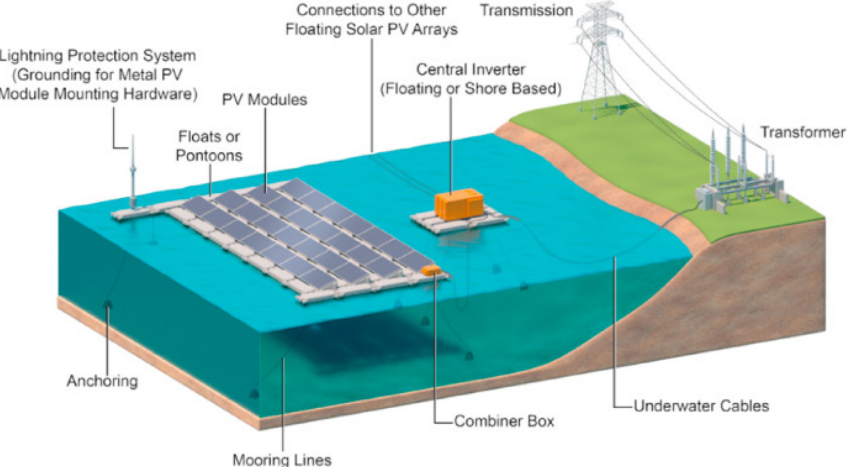
Figure 1. Representation of an FPV system, adapted from